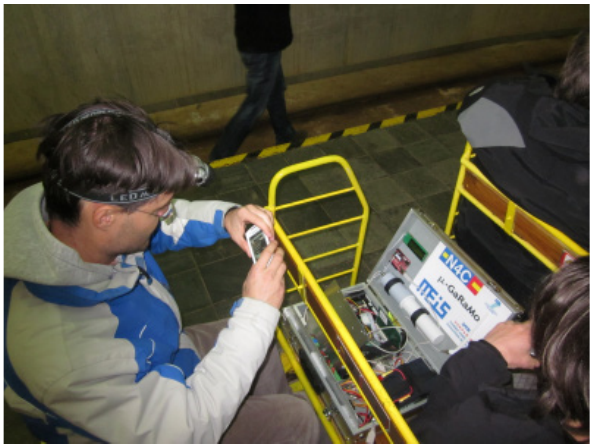
Fig. 7. Mobile DTN node based on Intel Atom embedded computer Figure 7. Mobile DTN node based on Intel Atom embedded computer mounted in a simple 3 mounted in a simple case with radiological probe and simple LCD case with radiological probe and simple LCD display presenting the current date and time, 4 display presenting the current date and time, number of connec- number of connections, number of bundles and last measured radioactivity (the node is 5 tions, number of bundles and last measured radioactivity (the node measuring gamma dose rate for other purposes; its basic task in the experiment is to act as the 6 is measuring gamma dose rate for other purposes; its basic task in mobile DTN “data mule” node for carrying data from cave to entrance). 7 the experiment is to act as the mobile DTN “data mule” node for carrying data from cave to